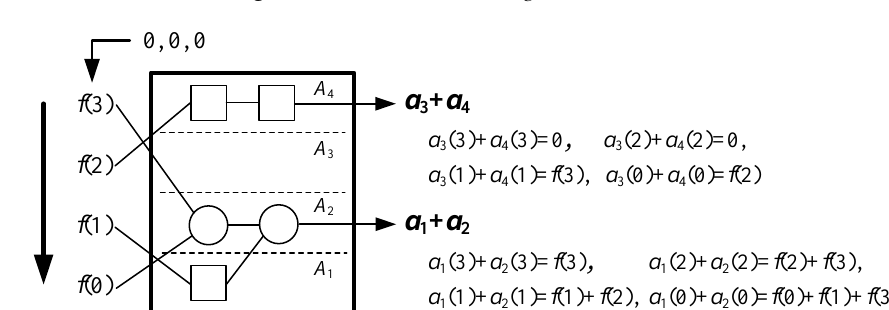
Figure 7. The module A for { g ( i ) } = {1, 2, 3, 4}.